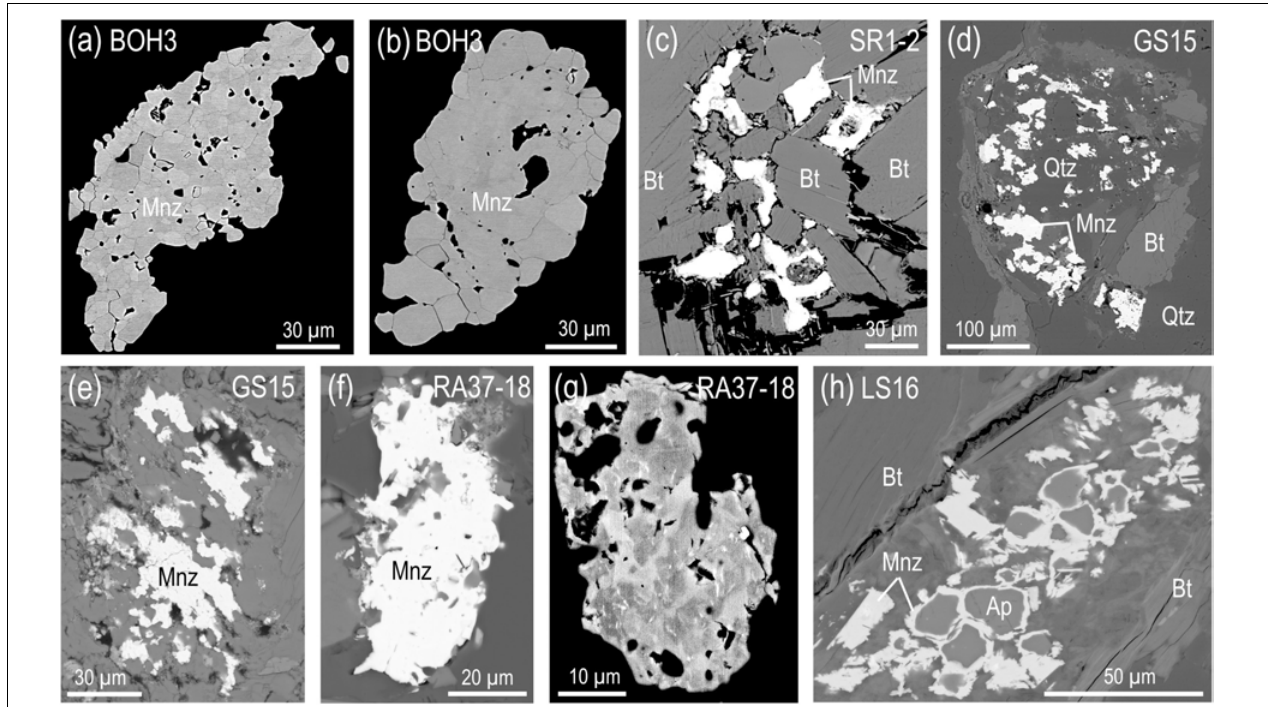
FIGURE 9 | Monazite crystallization and aggregation microstructures. (a,b) Large polycrystalline aggregates composed of numerous small monazite (Mnz) with static grain boundaries in high-grade mica gneiss from the Saxonian Granulite Massif. (c) Nucleation of small monazite in a biotite-rich domain (Bt) in a sheared Erinpura granitoid (Just et al., 2010). (d) Cluster-like assemblage of monazite grains with highly sutured and irregular grain boundaries, with quartz (Qtz) and biotite (Bt). (e) Larger monazites with highly sutured and irregular grain boundaries aggregated with surrounding smaller grains. (f,g) Aggregated monazite grains. The aggregated character can be recognized by irregular and sutured grain boundaries, the clumped small domains with different Th contents, and the numerous small inclusions (Oriolo et al., 2019). (h) Monazite rimming apatite (Ap) grains and forming a net-like aggregation in a micaschist from the Lower Unit in the Münchberg Nappe, Saxothuringian